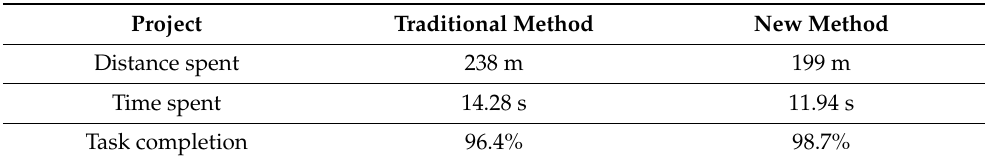
Table 1. Travel distance, time and task completion degree of the UAV under two mission plan- ning methods.